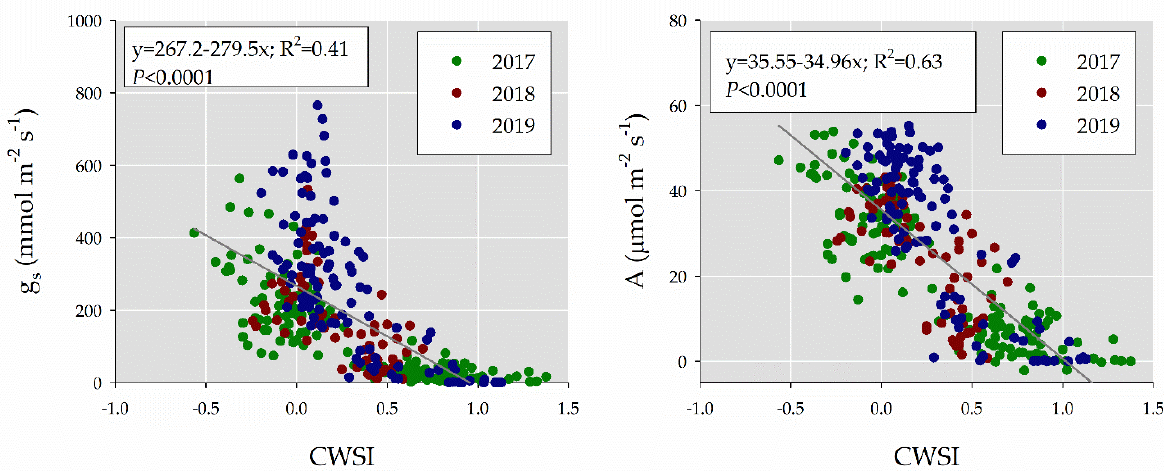
Figure 10. Relationship between crop water stress index (CWSI) and stomatal conductance (g s ) and leaf photosynthesis rate (A). Each point represents a single maize breeding plot. The straight grey lines depict the best-fit regression lines.